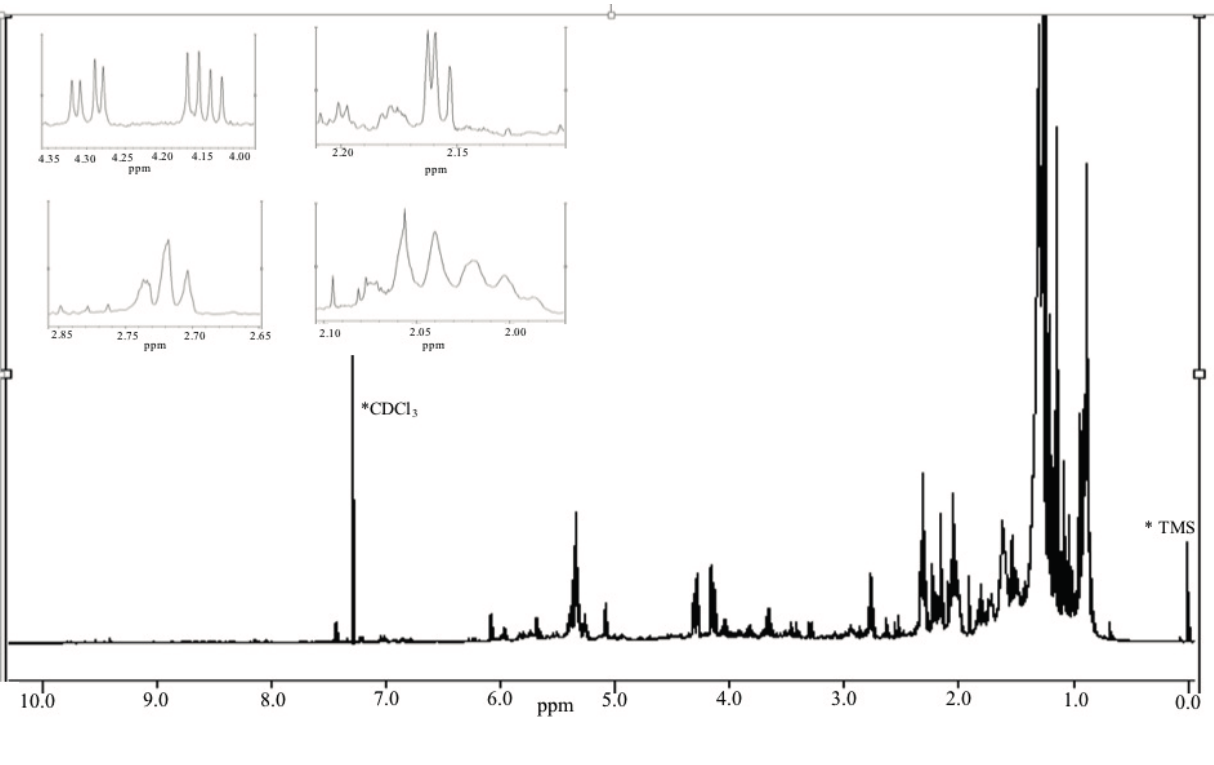
Figure 7. 1 H NMR of M12c lipidic fraction in CDCl